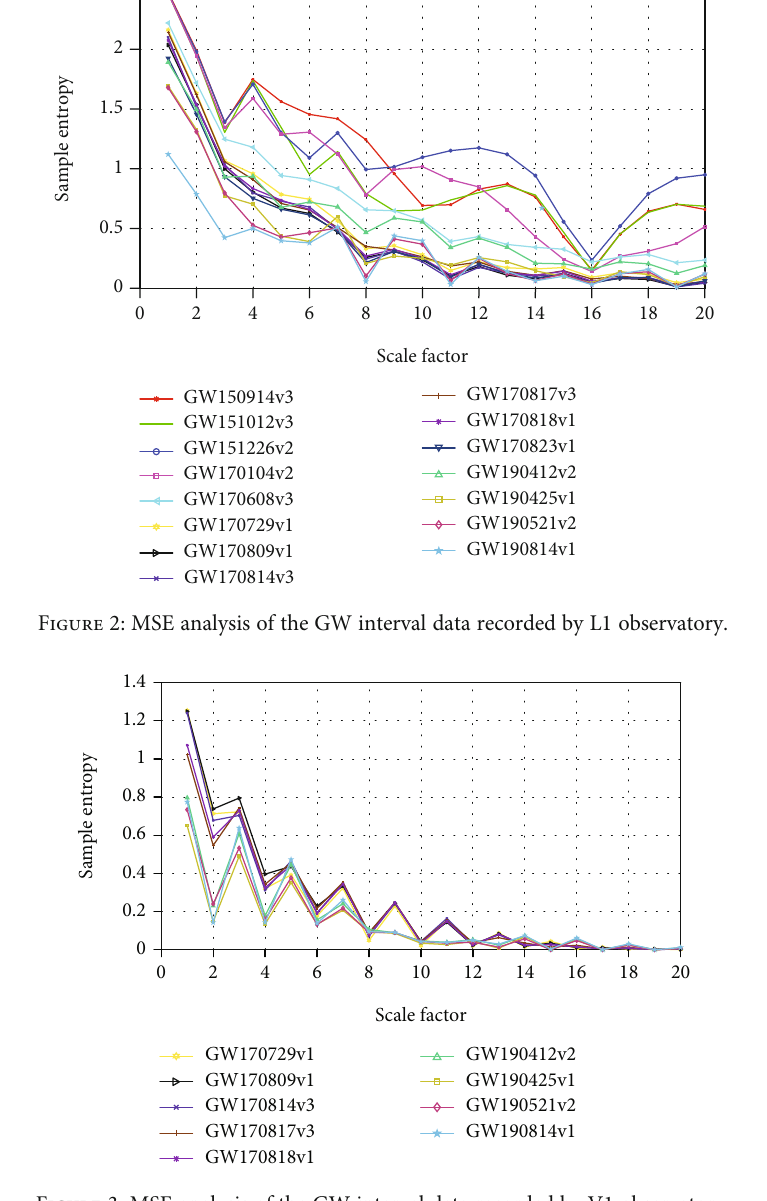
Figure 3: MSE analysis of the GW interval data recorded by V1